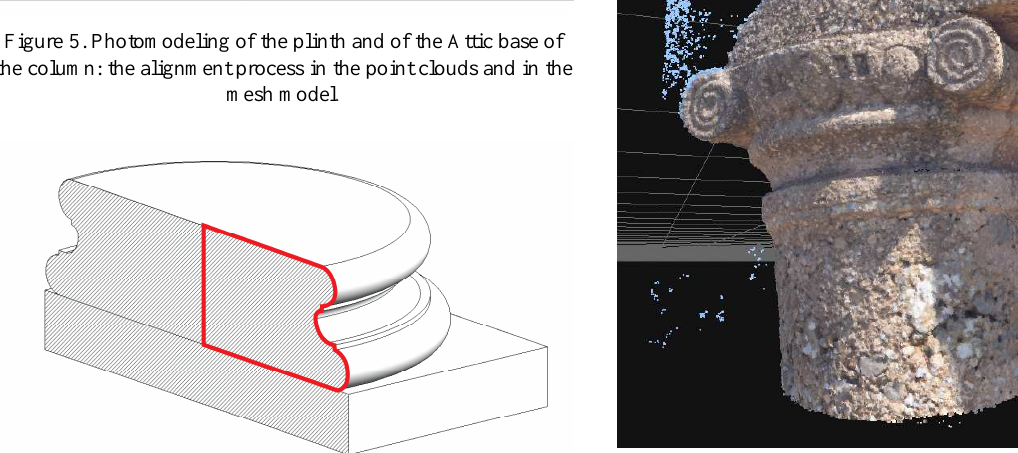
Figure 6. The profile used for the generation of the parametric model of the Attic base of the temple of Antas .